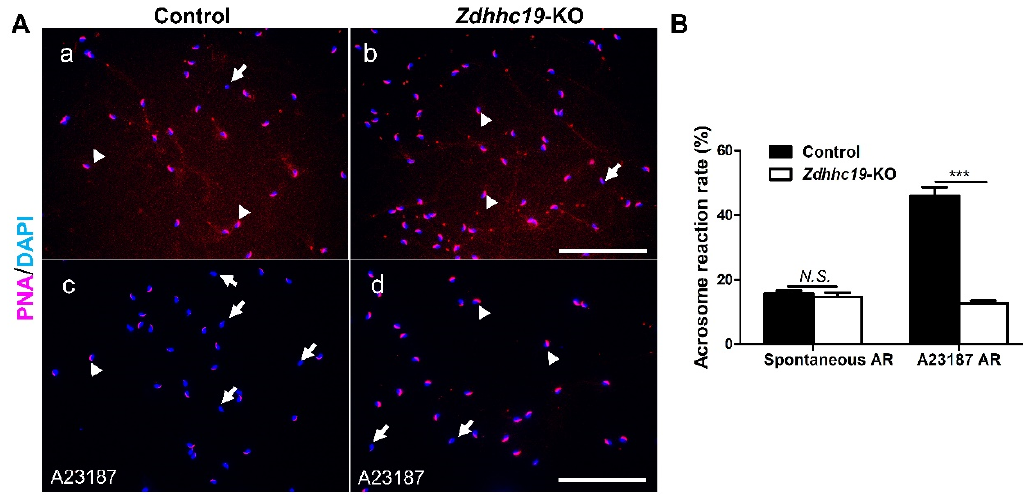
Figure 5. The induced acrosome reaction rate was significantly reduced upon Zdhhc19 KO . ( A ) Sperm without ( a , b ) or with treatment of A23187 ( c , d ) were stained with Rhodamine-PNA (red) and counter-stained with DAPI (blue). The acrosome-reacted sperm had DAPI-labeled nuclei but lacked PNA staining (white arrows), whereas intact acrosomes were stained positive for both PNA and DAPI-labeled nuclei (white arrow heads). Scale bars, 200 μ m. ( B ) The proportions of sperm that underwent spontaneous AR and induced AR were calculated from between Zdhhc19 KO and control littermates. Data are represented as the mean ± SEM of three sperm samples per group. N.S.: no significance; *** p < 0.001.